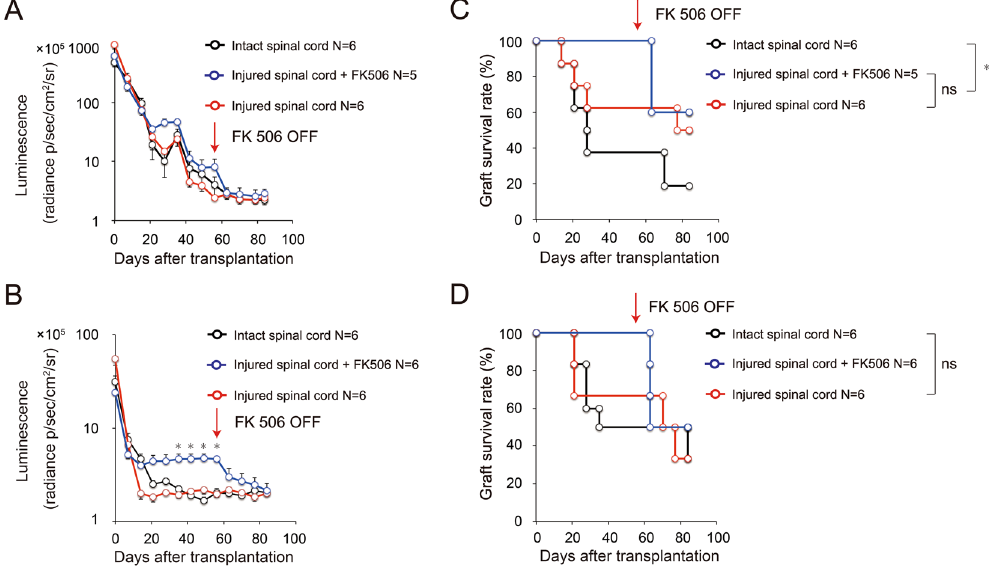
Figure 6. Bioimaging and graft survival rate after transplantation of fetus-NSPCs and iPSC-NSPCs into intact and injured spinal cords (with or without FK506) in MHC-mismatched BALB/cA mice. Quantitative analyses of the CPM derived from grafted ( A ) fetus-NSPCs and ( B ) 2A4F iPSC-NSPCs. Graft survival rates of mice transplanted with ( C ) fetus-NSPCs and ( D ) 2A4F iPSC-NSPCs. Each of the same populations of fetus-NSPCs and 2A4F iPSC-NSPCs were transplanted into intact spinal cords (intact spinal cord group, black), injured spinal cords (injured spinal cord group, red), and injured spinal cords in the presence of FK506 (injured spinal cord + FK506 group, blue) in BALB/cA mice. Follow-up examinations were performed using bioimaging. Values represent the mean ± SEM. * P < 0.05, one-way ANOVA followed by the Tukey–Kramer test. The graft survival rates were assessed using Kaplan–Meier survival curves. * P < 0.05, Gehan-Breslow-Wilcoxon test. ns, not significant. In ( A – D ), N indicates the number of